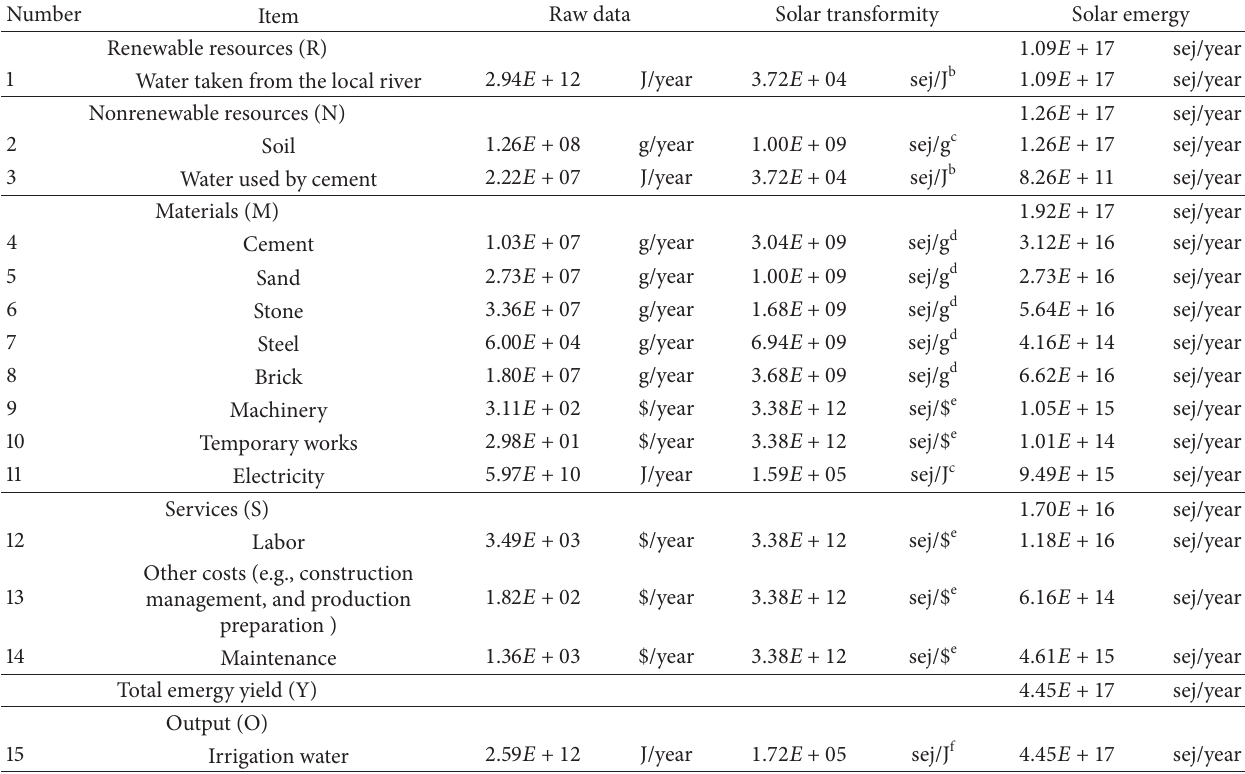
Table 2: Emergy evaluation of irrigation water production system a